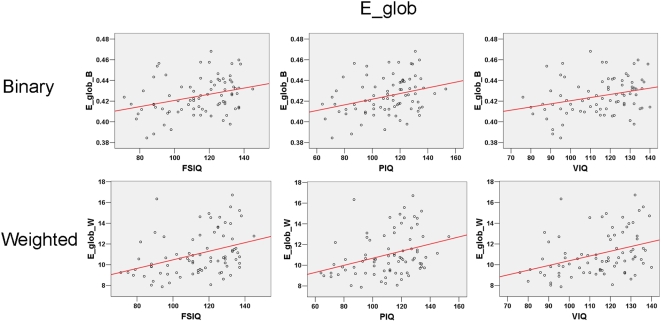
Significant partial correlation between E_glob and intelligence tests scores.
 was found to be positively correlated to FSIQ, PIQ and VIQ in both the binary and weighted networks.